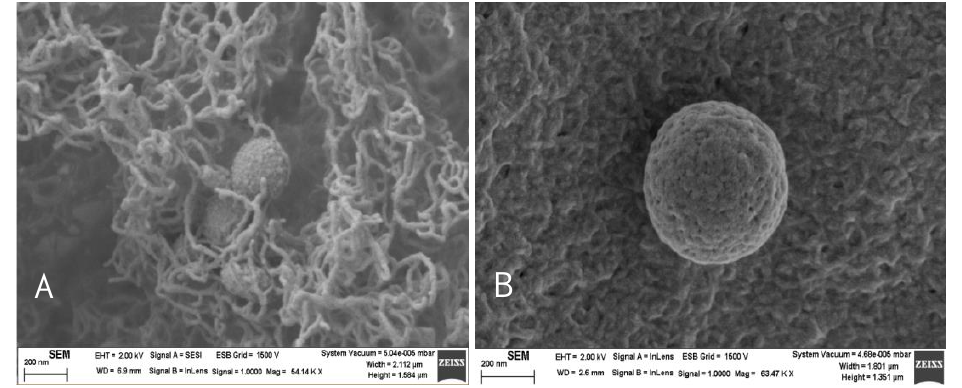
Figure 6. SEM images of RuC11C11- and RuC19C19-liposomes ( A and B , respectively). α = 0.2. Scale bar = 200 nm.